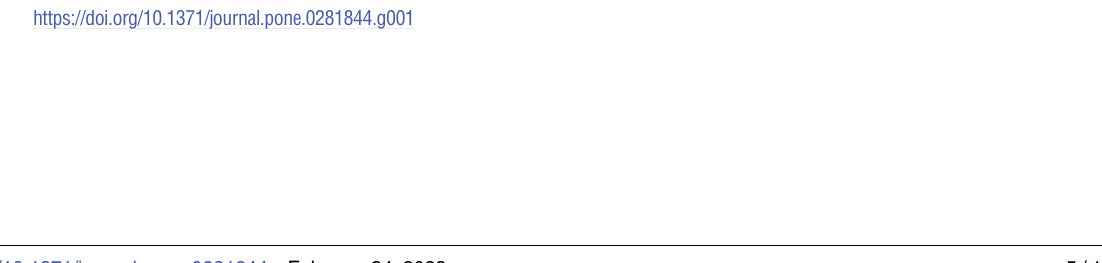
PLOS ONE | https://doi.org/10.1371/journal.pone.0281844 February 24,